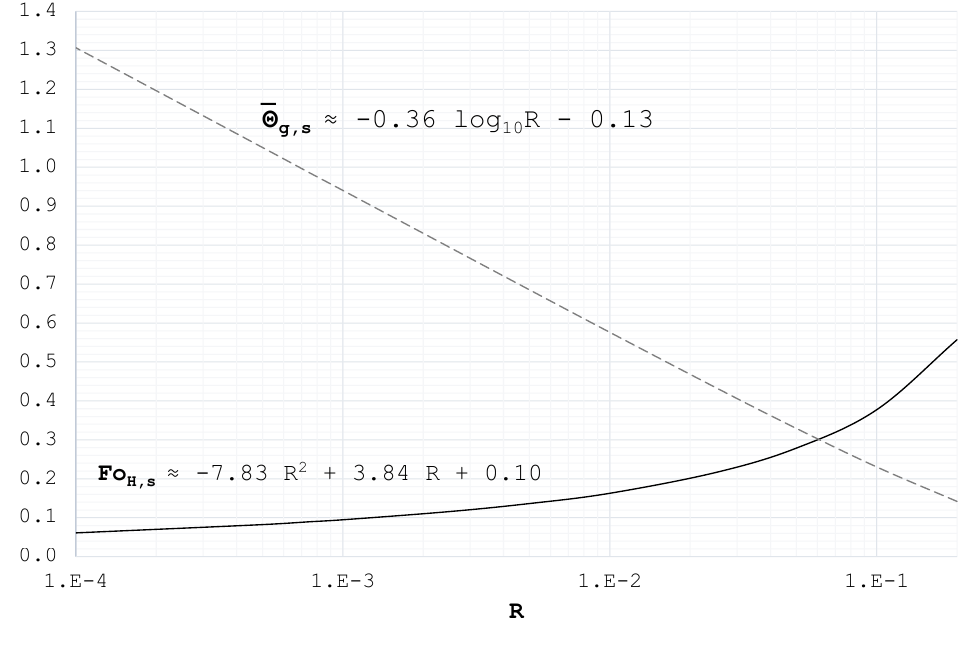
Figure 7. FLS model: steady state Θ g , s and Fo H , s as a function of R